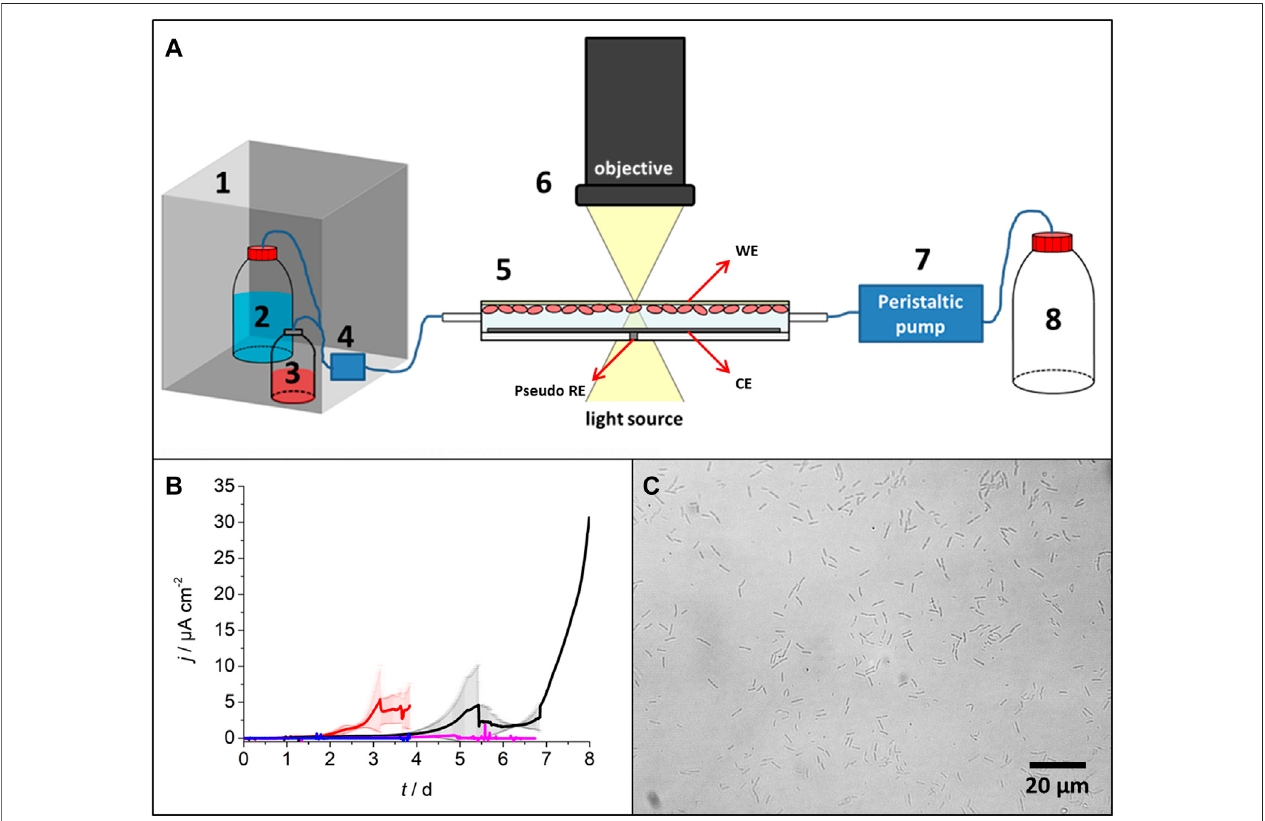
FIGURE 1 | (A) Schematic experimental setup including the anaerobic box (1), medium bottle (2), inoculum (3), bubble trap from Weiss Nielsen et al. (2011) (4), electrochemical fl ow-cell (EFC)with apseudo-referenceelectrode (pseudo-RE),working electrode (WE) and counter electrode (CE) (5), microscope (6),peristaltic pump (7),andwastebottle(8). (B) Chronoamperometricmeasurementofthebio fi lmgrowingontheAuPdWEat+150 mVvs.Ag/AgClsat.KClintheEFC.Redandblacklines indicate the average value of the current density of the experiments performed with pre-cultures 1 and 2 as the inoculum, respectively (each n = 3). Red and black shadowed areas indicate standard deviations. Blue line: negative control without inoculation; magenta line: bio fi lm cultivation in the presence of additional 50 mmol L − 1 2-BES. (C) Optical microscopy picture of the AuPd WE with cells. Experiments were carried out till a multi-layered bio fi lm started to appear ( Section 2.4 and Supplementary Figure S3